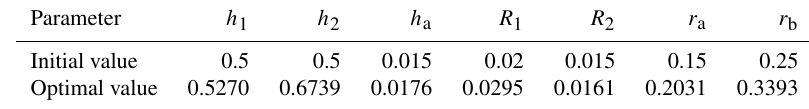
Table 5. Design values of the main parameters of 2RPU-2SPR over a constrained parallel mechanism. Parameter h 1 h 2